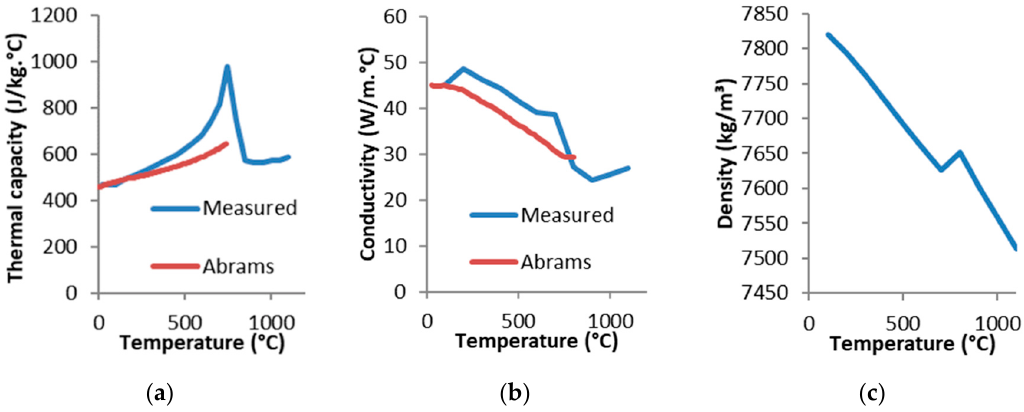
Figure 7. Differential scanning calorimetry (DSC) measurement showing the latent heat of fusion of M4 (scanning rate of 3 °C/s).